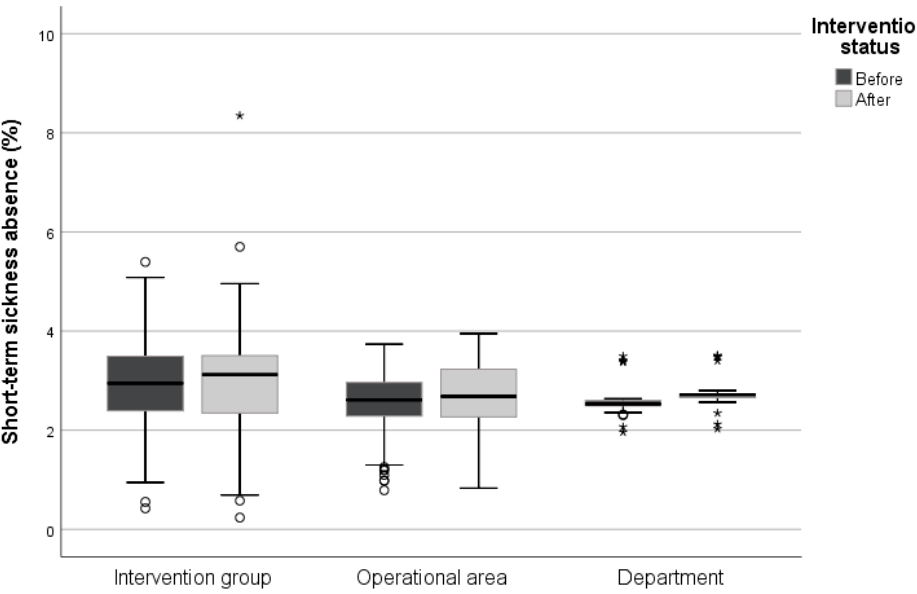
Figure 3. The distribution of the workplace means employee turnover and sickness absence before and after the intervention.